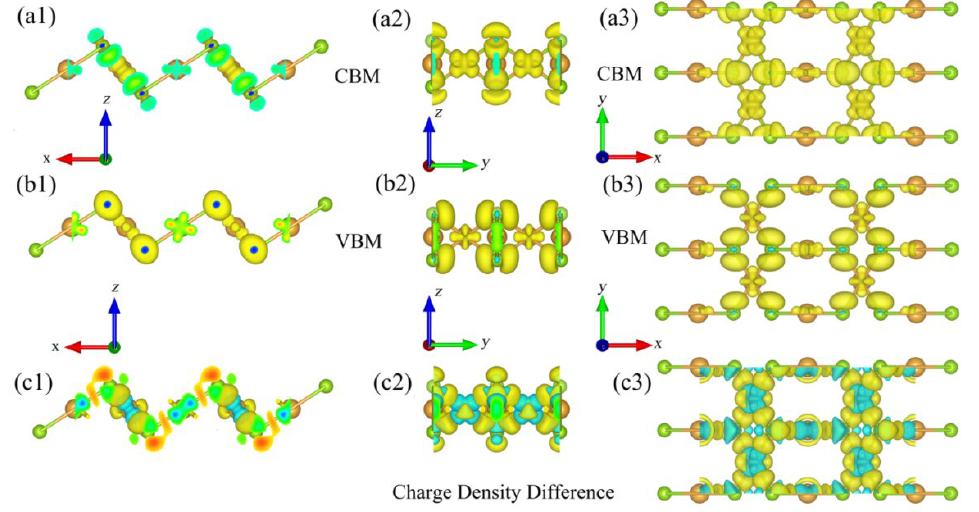
Figure 4. ( a1 – a3 ) Charge density (CD) of monolayer β -AuSe’s CBM in different views, where the isosurface level is set to 0.01. ( b1 – b3 ) Charge density (CD) of monolayer β -AuSe’s VBM in different views, where the isosurface level is set to 0.01. ( c1 – c3 ) The charge density difference of monolayer β -AuSe, where the isosurface value is set to 0.006. The blue and yellow in panels ( c1 – c3 ) represent losing and gaining electrons.